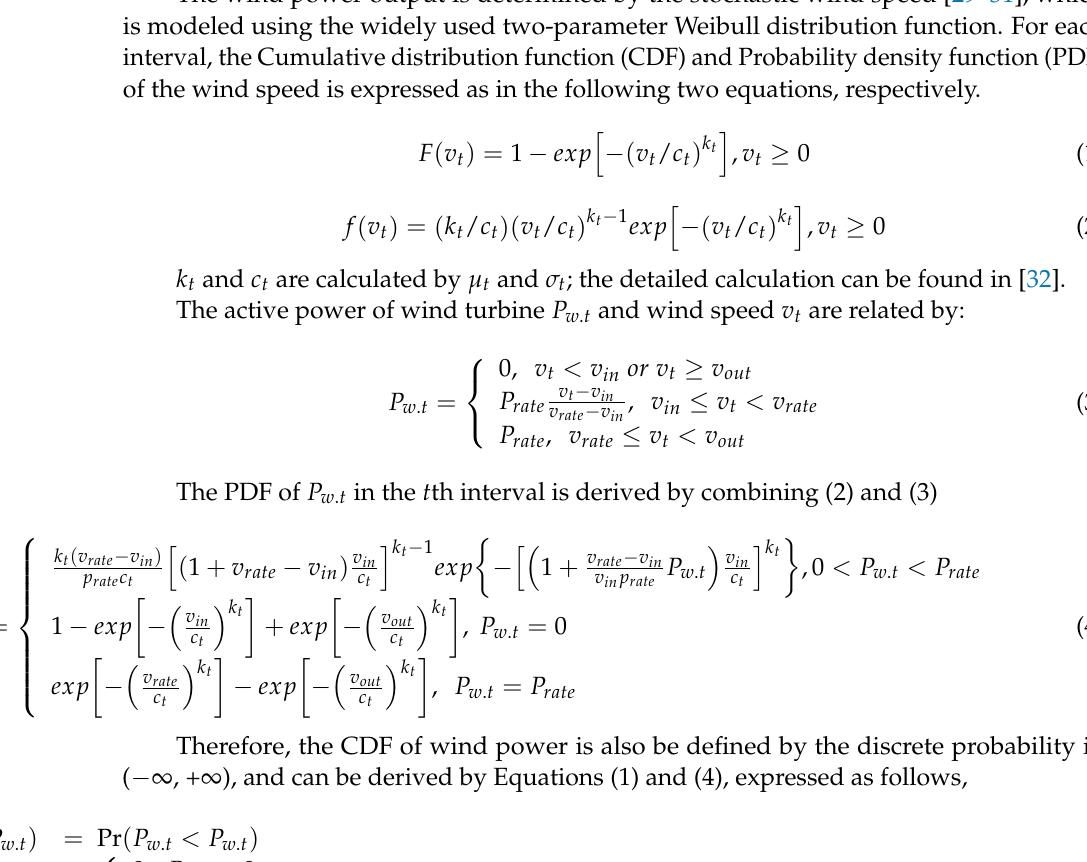
rate power charging and discharging SOC remaining capacity of electric vehicle